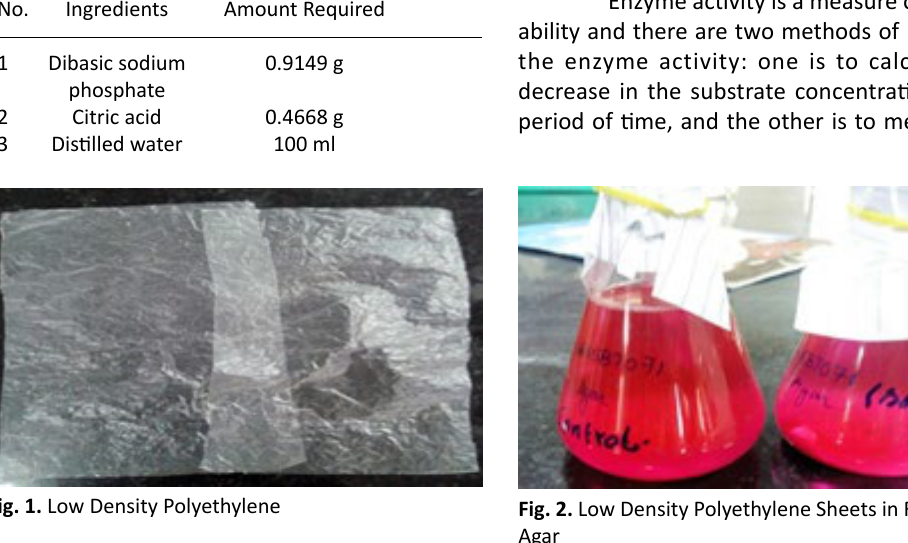
Table 1. Composition for Citrate Phosphate Buffer No.